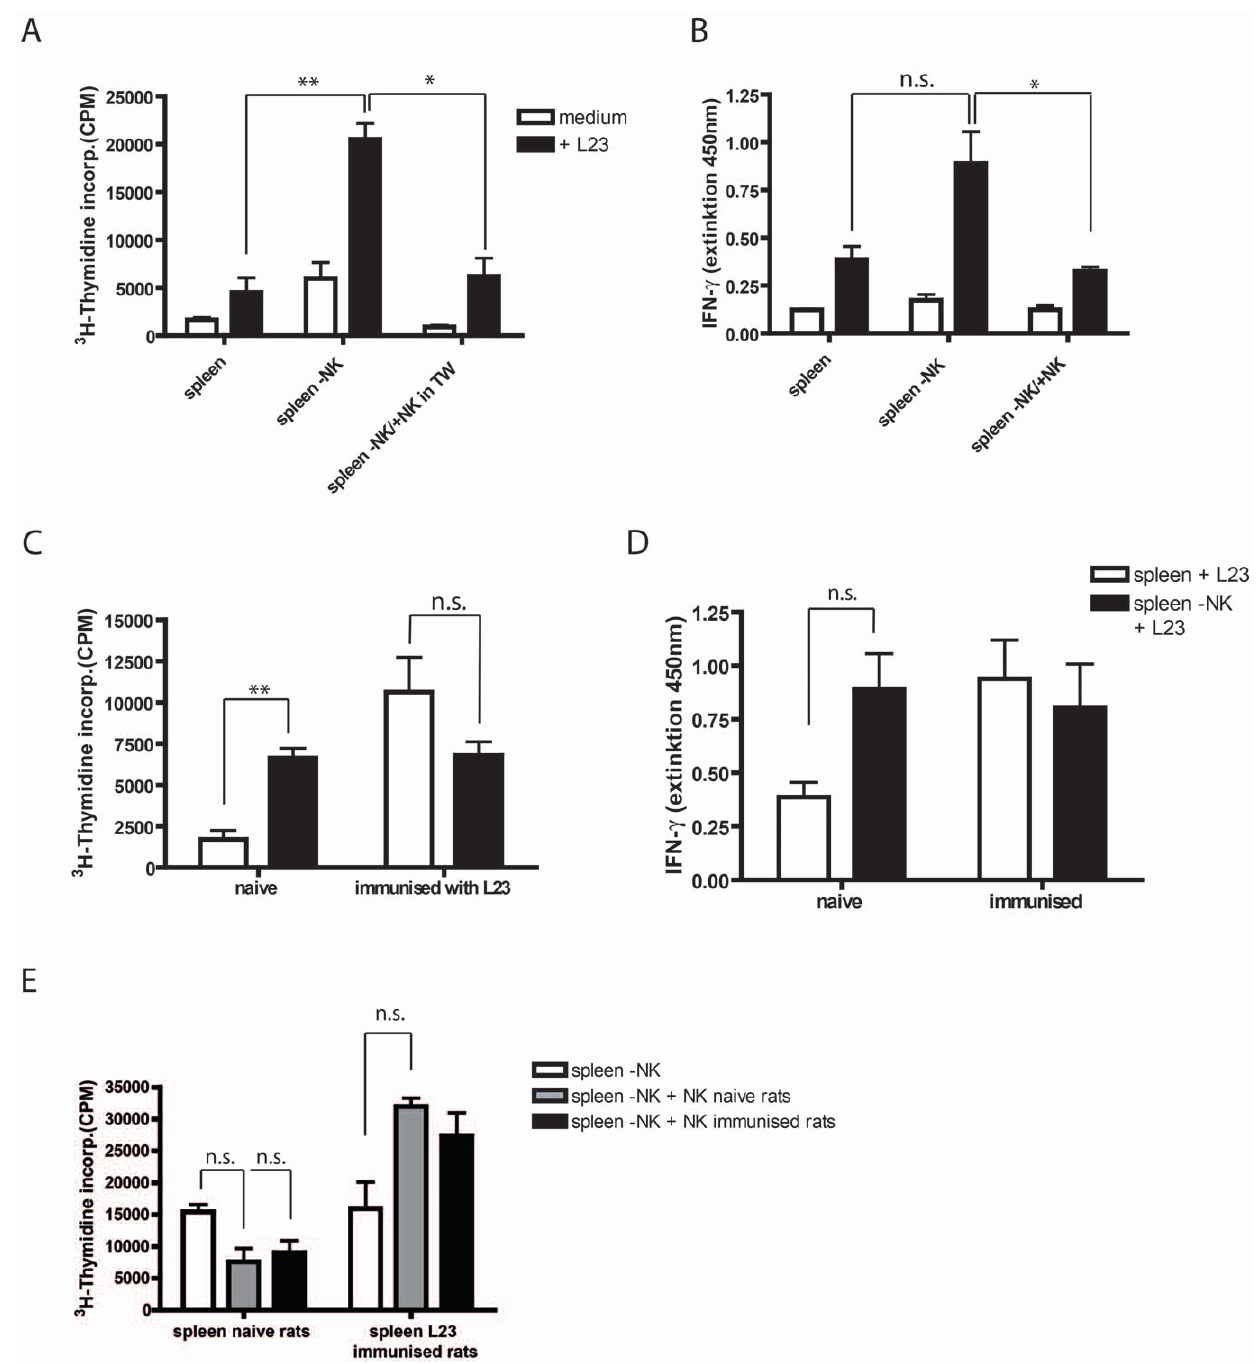
Figure 6. NK cells control the response of naı¨ve but not of activated T cells. A: To confirm that NK cells rather control the T cell response than suppress, 2 6 10 5 splenocytes were depleted of NK cells and response to 2 6 10 3 L23 was assessed in the absence or presence of 2 6 10 4 NK cells incubated in transwells. Depletion of NK cells increased the proliferative response of splenocytes significantly which could be reversed by contact independent return of NK cells in transwells (TW). B: The control of proliferation of T cells by NK cells in bulk splenocytes is combined with a control of cytokine response e.g. IFN- c as one of the important inflammatory cytokines. C: For evaluation of regulatory function of NK cells at different stages of immune response, 2 6 10 5 splenocytes from naı¨ve and 14 days L23-immunised LEW.BH-NKC rats were used as responder cells. Splenocytes were incubated as bulk or NK depleted cells with 2 6 10 3 L23 cells. Thus, for naı¨ve cells this was the initial stimulation, for immunised splenocytes it was a specific re-stimulation. The naı¨ve spleen cells responded to L23 stimulation with increased proliferation after NK-depletion whereas using immunised splenocytes a decrease in proliferation was detected. D: Assessment of IFN- c revealed a strong increase in cytokine secretion in naı¨ve splenocytes depleted of NK cells but a decrease in NK-depleted immunised splenocytes. E: To evaluate if NK cells derived from immunised rats lost the regulative capacity, 2 6 10 5 spleen cells from naı¨ve and immunised rats were depleted of NK cells, stimulated with 2 6 10 3 L23 cells and cross-incubated with 2 6 10 4 purified naive NK cells or derived from immunised rats. Stimulation of NK-depleted splenocytes with L23 cells induced comparable proliferation in spleen cells derived from immunised and rats. While the proliferation of naive splenocytes could be influenced by both NK cells